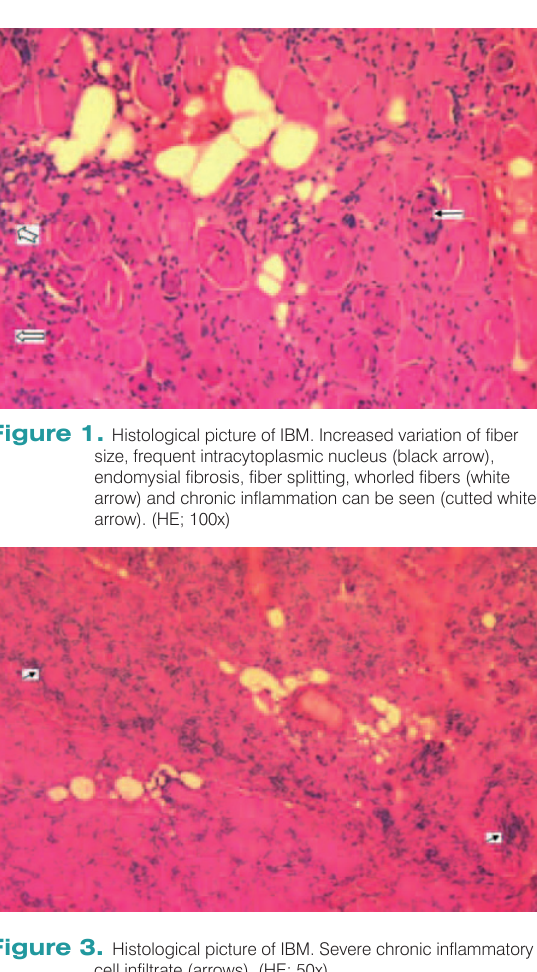
Figure 3. Histological picture of IBM. Severe chronic infl ammatory cell infi ltrate (arrows). (HE; 50x)